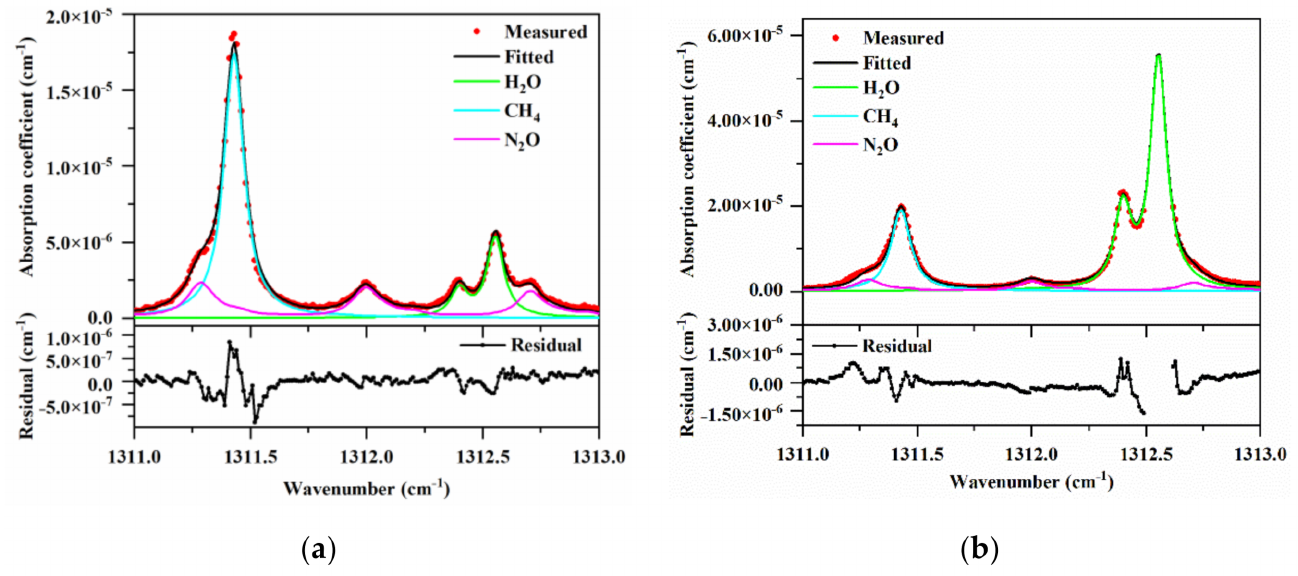
Figure 6. ( a ) The first and ( b ) eighth measured and fitted spectra and the corresponding